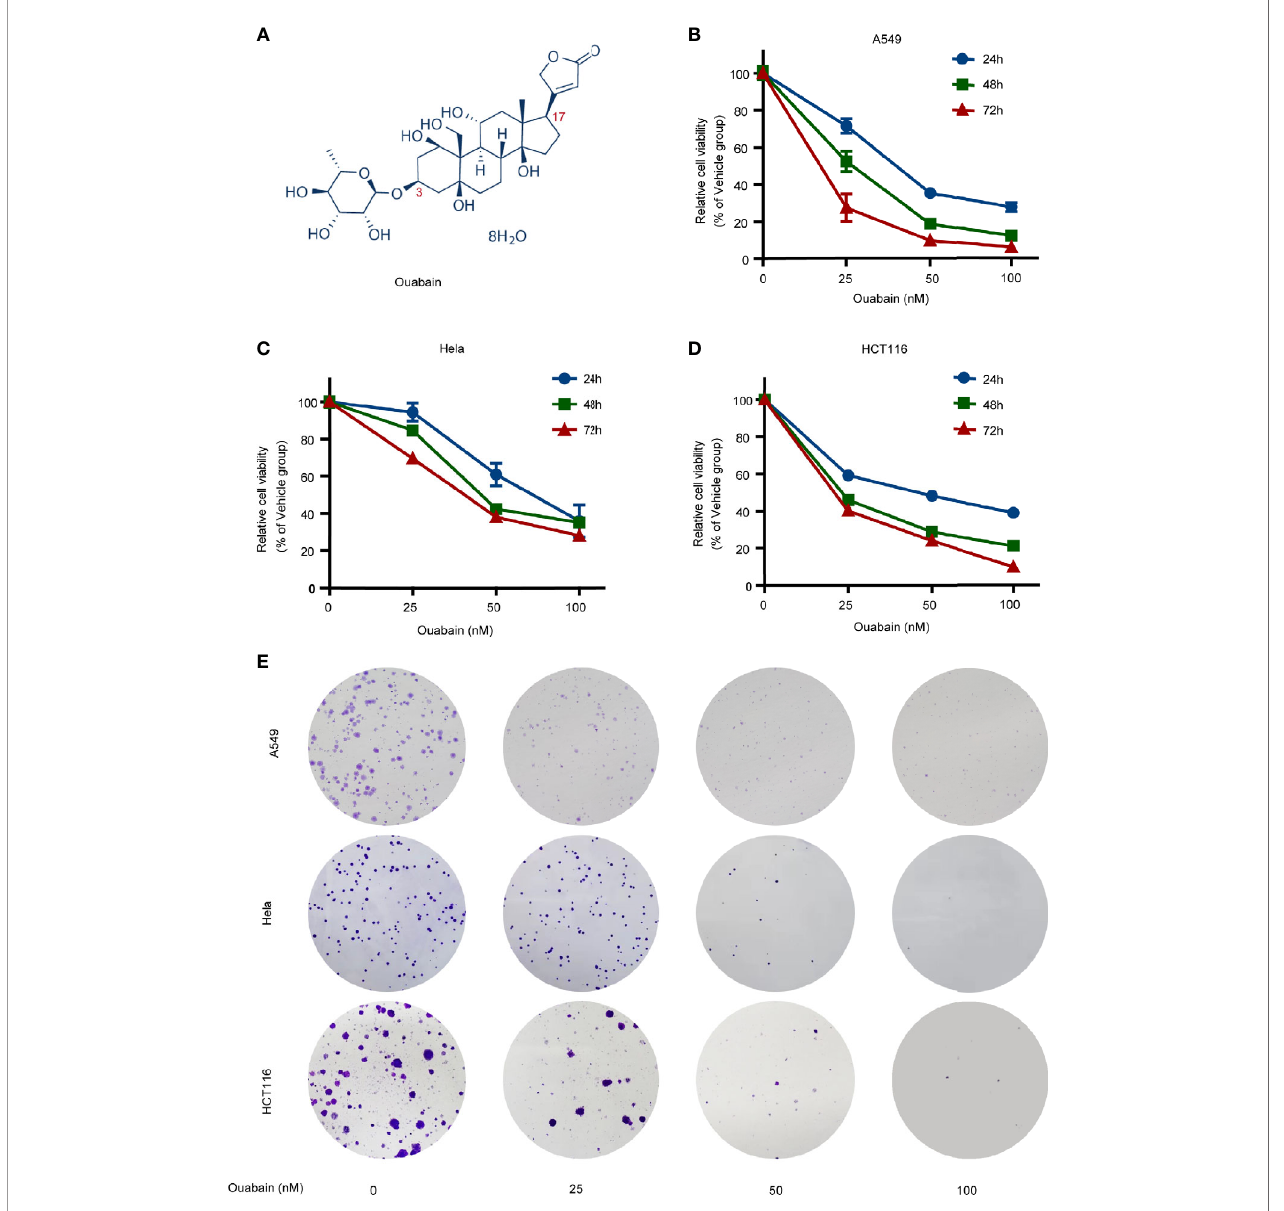
FIGURE 1 | Effects of ouabain on the viability and clonogenicity of various cancer cells. (A) Chemical structure of ouabain. (B – D) A549, Hela and HCT116 cells were treated with ouabain (0-100 nM) for 24, 48 or 72 hours and cell viability was determined by CCK-8 assay. (E) A549, Hela and HCT116 cells were treated with different doses of ouabain (0, 25, 50, 100 nM) for 24 hours and cell clonogenicity were measured by colony formation